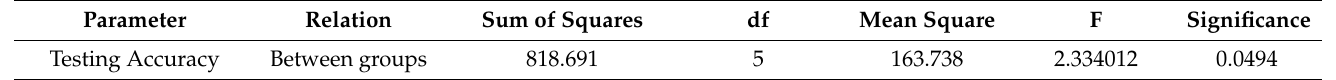
Table 3. One-way ANOVA result test of QRS with Opposition-Based PSO approaches.